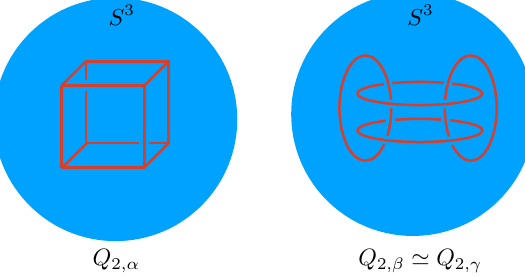
Figure 2 . The base 3-orbifolds for the α , β , and γ fibrations of the G 2 orbifold X 2 . In all cases, the base orbifold is of the form T 3 / Z 2 , and is homeomorphic to a 3-sphere. There is a 1-dimensional 2 locus of singularities that in the case of the α -fibration is the 1-skeleton of a cube, while in the β - and γ -fibrations it is a doubled Hopf link. These orbifolds serve as the bases for the fibrations of X 3 as well, with Q 3 ,α ’ Q 3 ,β ’ Q 2 α and Q 3 ,γ ’ Q 2 ,β ’ Q 2 ,γ . The dual heterotic geometries are T 3 fibrations over the same